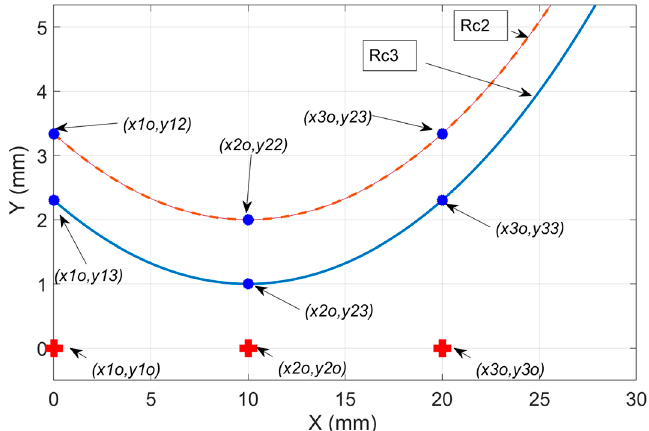
Figure 5. Mathematical simulation of calibration procedures: the circles are constructed for (𝑎 (cid:3030) , 𝑏 (cid:3030) ) = (10,40) mm and two radii 𝑅 = {38, 36} mm by using two parametric functions 𝑡 = cos (cid:2879)(cid:2869) ((𝑎 (cid:3030) − 𝑥) 𝑅⁄ ) and 𝑦 = 𝑏 (cid:3030) − 𝑅 𝑠𝑖𝑛(𝑡) . Table 1. Parametric simulation of the displacements between sensor coordinates and the calibration master. 𝑹 = 𝟑𝟖. 𝟎𝟎 𝐦𝐦 𝑹 = 𝟑𝟗. 𝟎𝟎 𝐦𝐦 𝒄𝟐 𝒄𝟑 Sensor Simulated Sensor Simulated 𝑦 (cid:2869)(cid:2870)